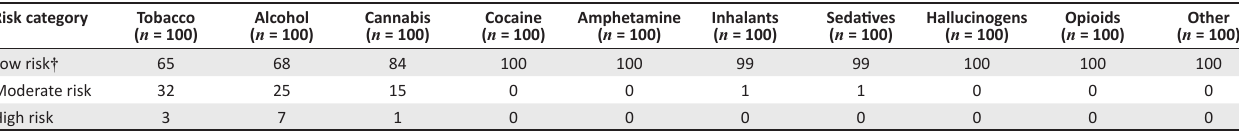
TABLE 4: Breakdown of Alcohol, Smoking and Substance Involvement Screening Test-defined substance abuse risk. Risk category